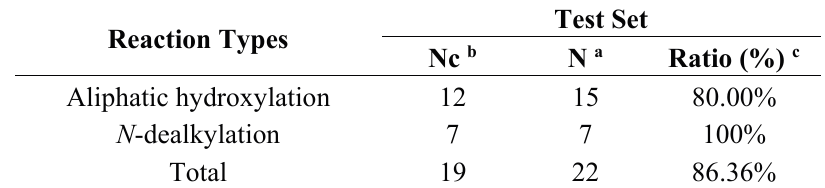
Table 3. Prediction accuracy for the test set using the top three sites for the mechanism-based prediction